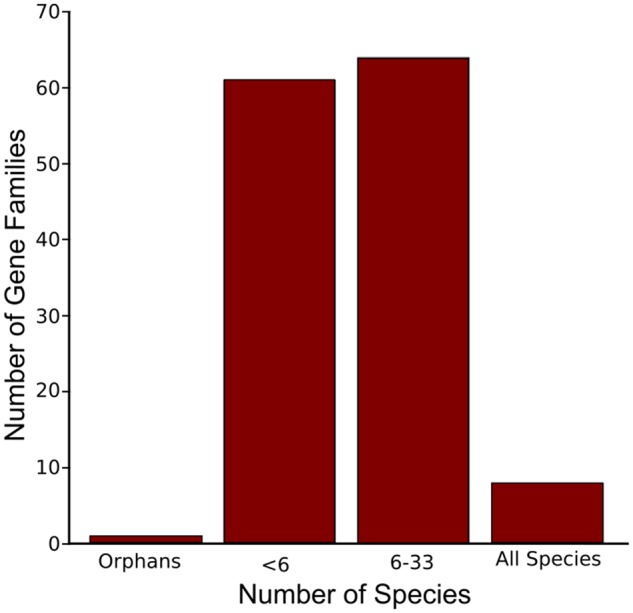
Size of orthology clusters to which imprinted Arabidopsis thaliana genes belong. Orphans are defined according to (Donoghue et al. 2011); genes present in orthology clusters >6 were considered for further selective pressure variation analysis.